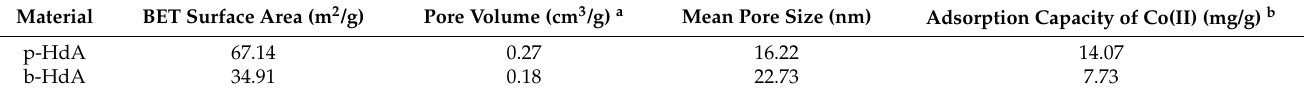
Table 1. Elemental compositions of the p-HdA and b-HdA.